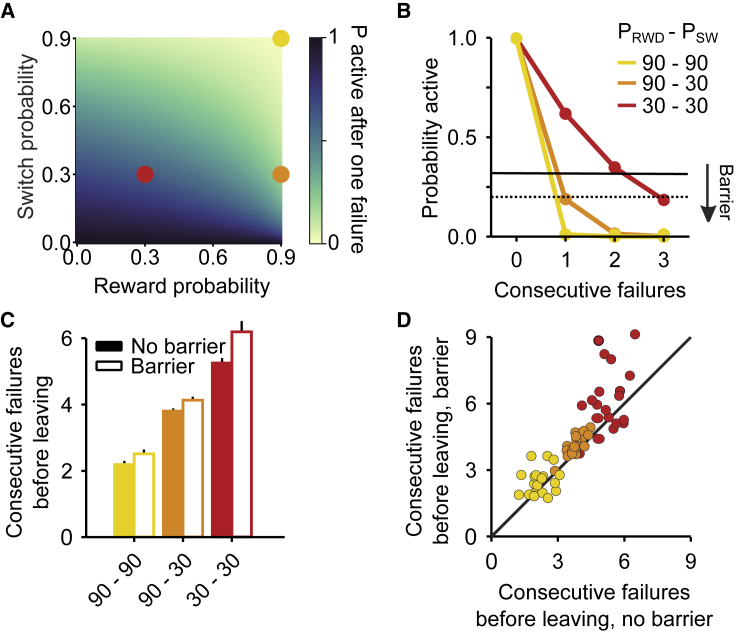
Accumulation of Inferred Evidence Is Tuned to Task Parameters(A) Probability of being on the correct site after a failure as a function of reward probability and transition probability.(B) Probability of being on the correct site as a function of trial history for three protocols (Easy environment: pRWD = 0.9 and pSW = 0.9; Medium environment: pRWD = 0.9 and pSW = 0.3; Hard environment: pRWD = 0.3 and pSW = 0.3). Leaving decisions can be modeled by setting a threshold on this probability that changes as a function of the travel cost (black lines).(C) Consecutive failures before leaving as a function of the environment statistics and barrier condition. Error bars represent SEM across animals.(D) Consecutive failures before leaving split by subject and environment statistics, barrier versus no barrier.